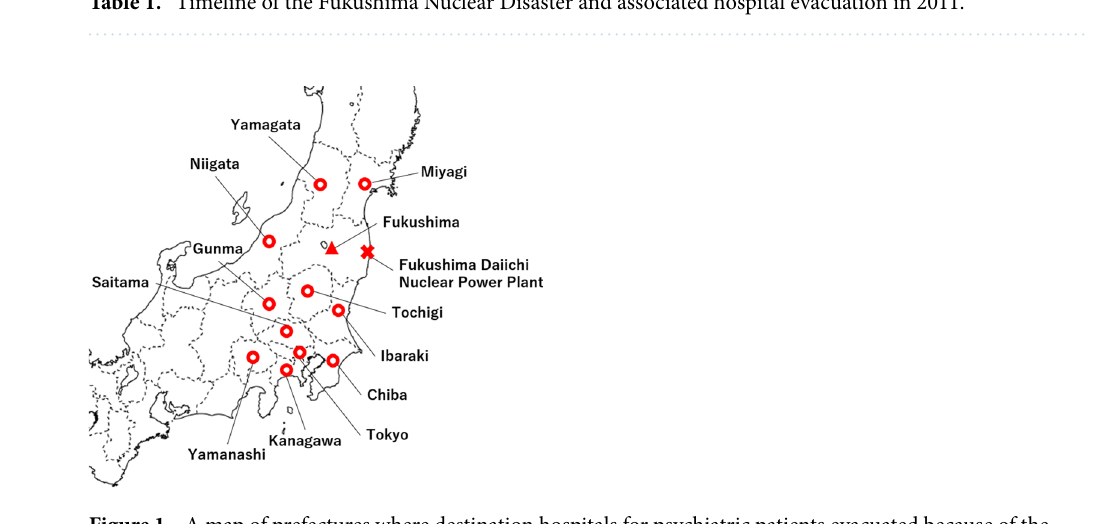
Table 1. Timeline of the Fukushima Nuclear Disaster and associated hospital evacuation in 2011.